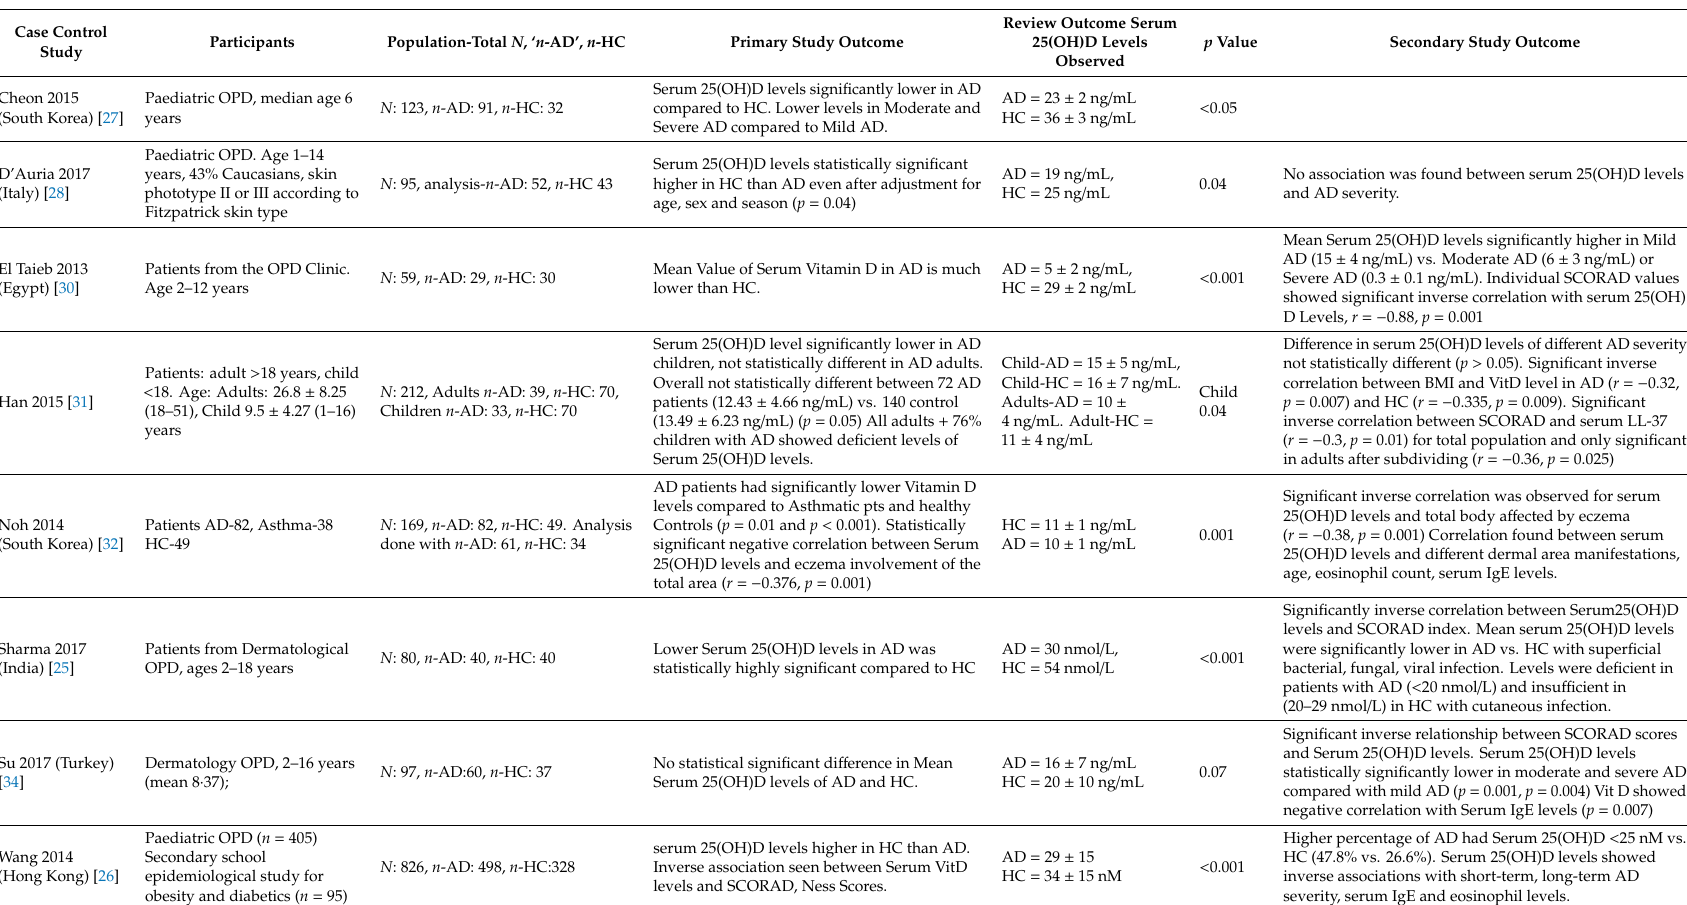
Table 1. Observational case-control studies of serum 25(OH)D levels in atopic dermatitis individuals compared to healthy controls. Case Control